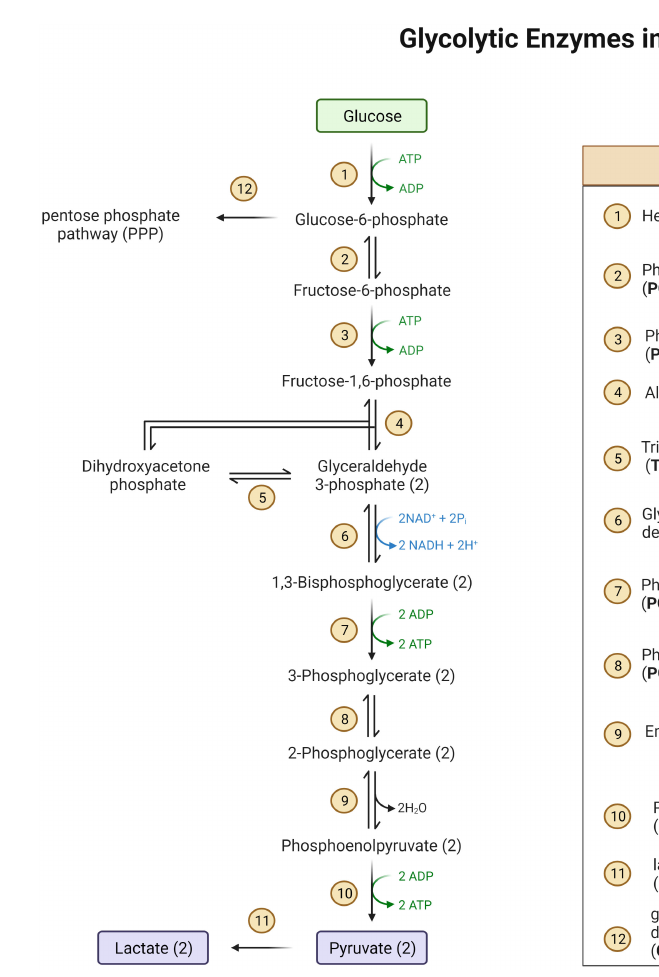
FIGURE 1 A diagram of glycolysis and glycolic enzymes involved in the regulation of immune